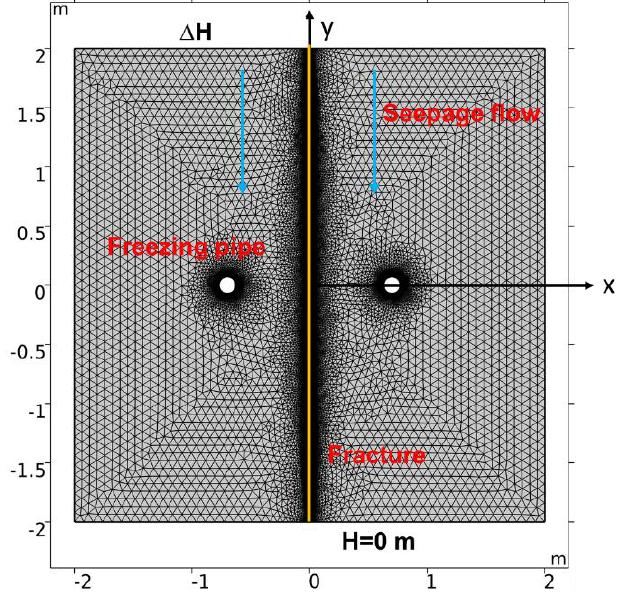
Figure 2. The calculation model for single − fractured porous media rock mass. Table 1. Parameters related to the freezing process in fractured rock mass [27,29].